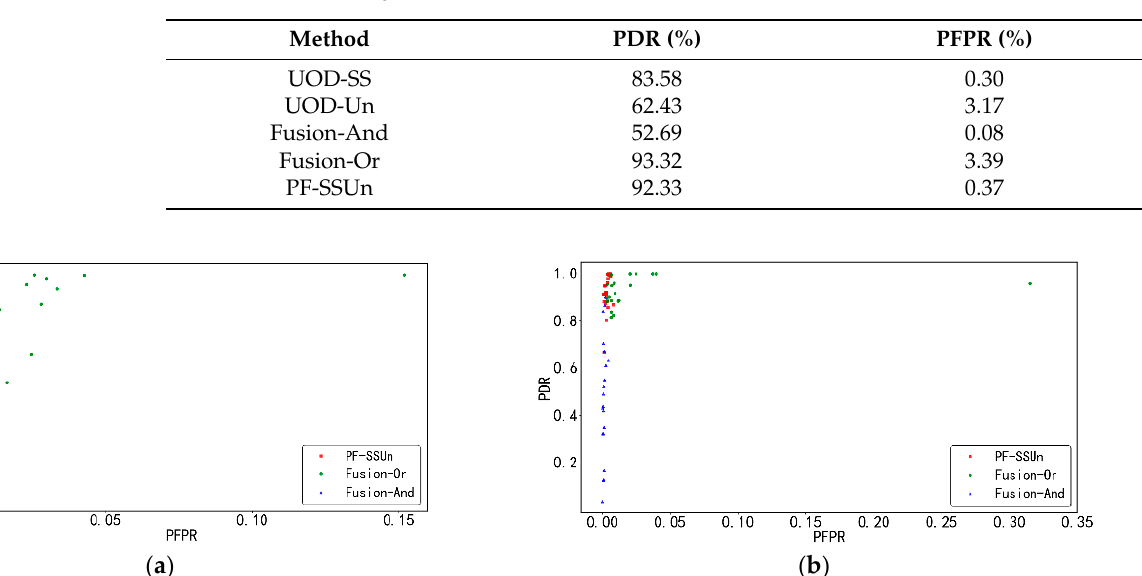
Figure 9. PDR over PFPR scatter plot of the three semantically relevant methods: ( a ) Scene 1; ( b ) Scene 2.